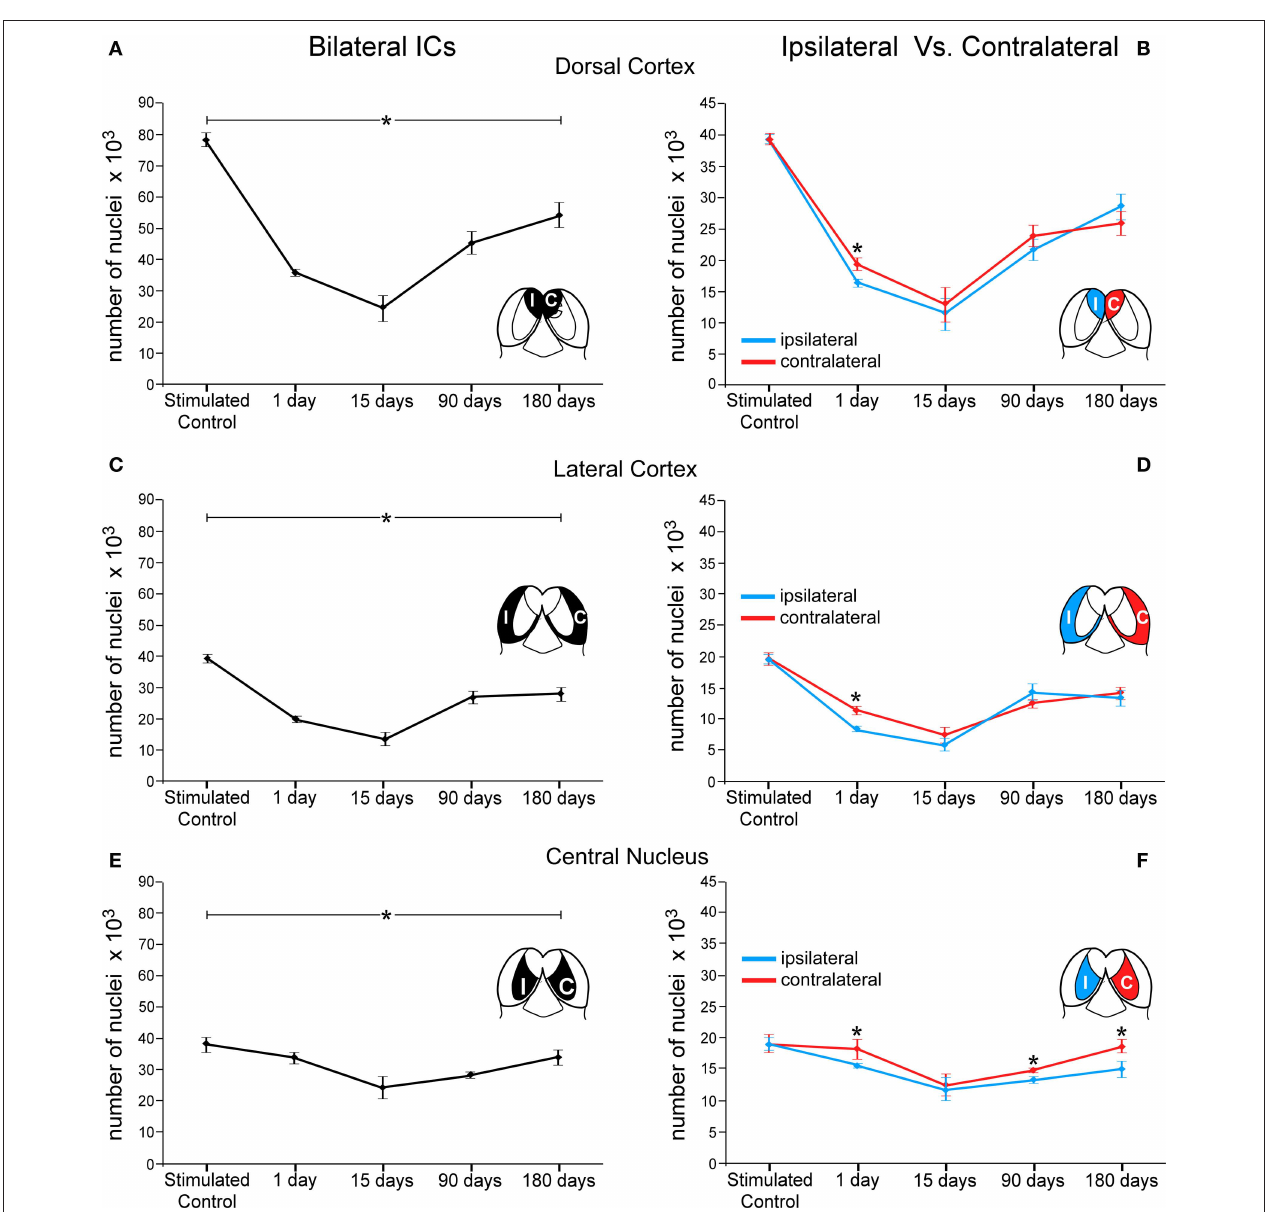
asterisks show significant differences in c-Fos immunoreactive nuclei between the sides ipsi- and contralateral to the lesion. In animals stimulated 1 day after the cortical lesion, the number of c-Fos immunoreactive nuclei is significantly lower in the ipsilateral side in the three IC subdivisions (*DC: 15%, EC: 27%, and CN: 14%). In the central nucleus (F) , the contralateral side shows significantly higher numbers of immunoreactive nuclei after 90 and 180 days of the cortical lesion (*10% and 20%,